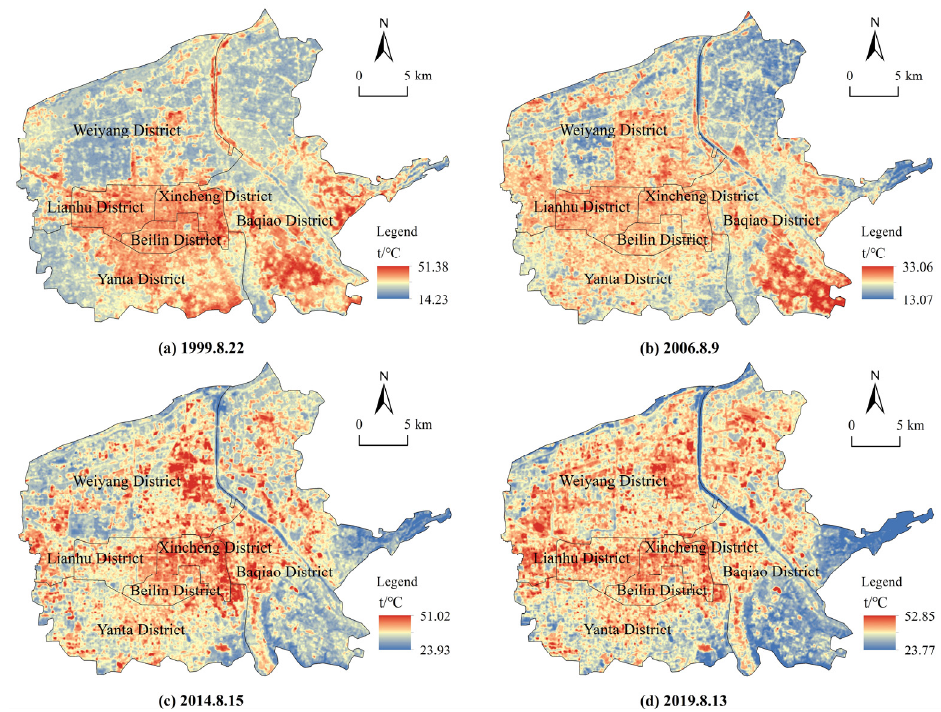
Figure 2. Spatial distribution of surface temperature in central Xi’an for four periods.